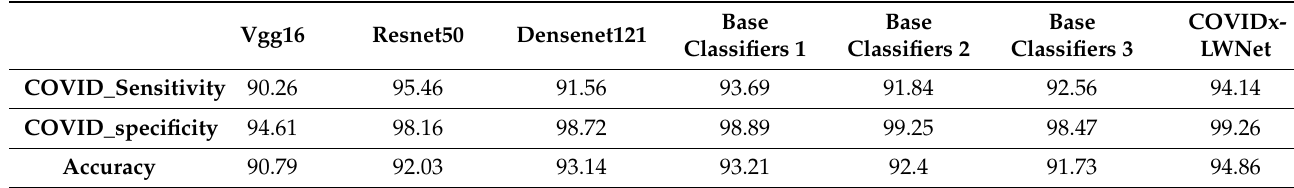
Table 11. D3_2:D3_2 (train: test), four-class.